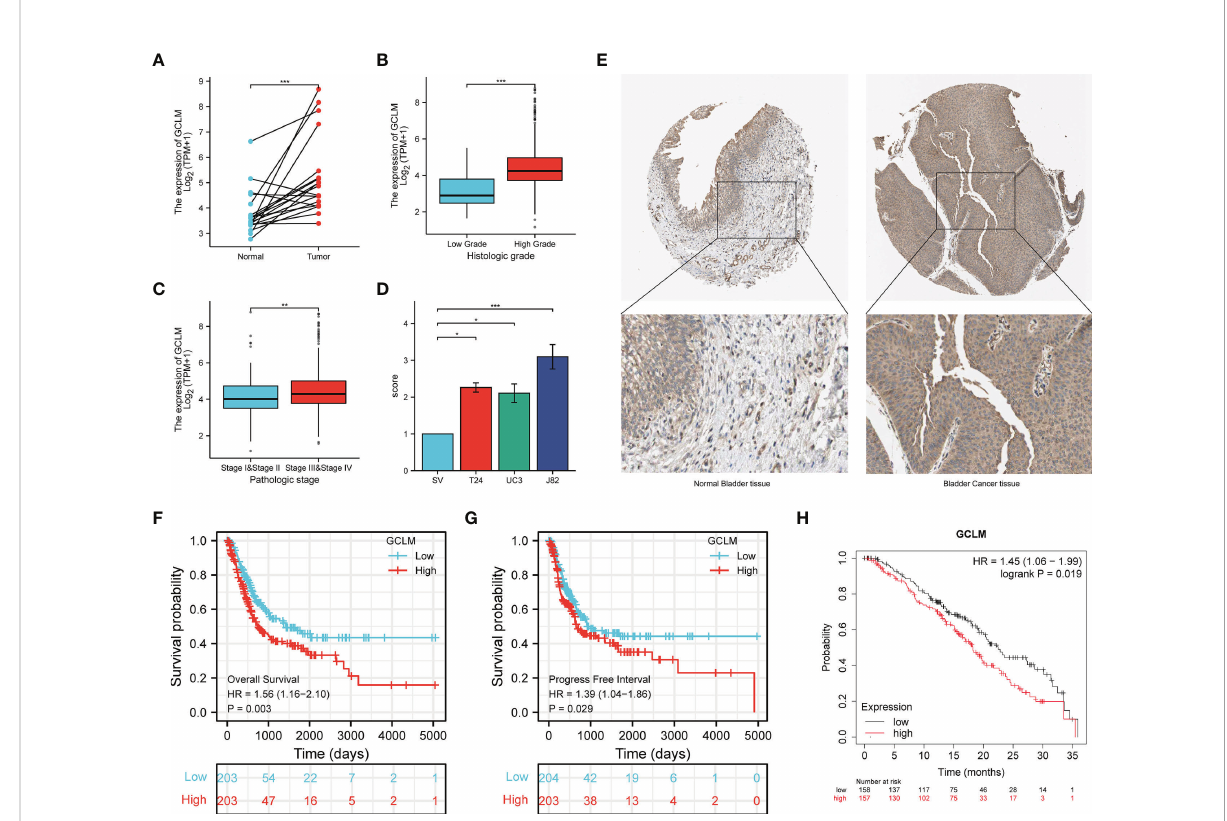
FIGURE 6 GCLM is highly expressed in BCa and its elevated expression correlated with unfavorable prognosis. (A) GCLM is highly expressed in 19 paired BCa and normal bladder tissues in TCGA-BLCA cohort. GCLM expression is associated with higher tumor histologic grade (B) and pathologic stage (C) in BCa. (D) GCLM is highly expressed in BCa T24, UC3 and J82 cell lines compared to normal bladder cell line SV. (E) The IHC stain of GCLM in normal bladder tissue (left) and bladder cancer tissue (right). Overexpression of GCLM predicts unfavorable (F) OS and (G) PFI in TCGA- BLCA cohort. (H) Overexpression of GCLM predicts unfavorable OS of BCa patients in Kaplan-Meier plotter database. *p < 0.05; **p < 0.01, ***p <